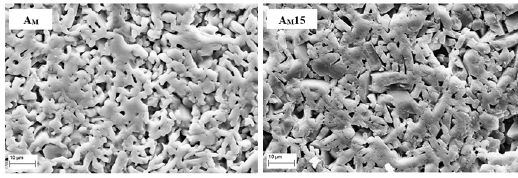
(1,600 ºC/7 h, d M = rel